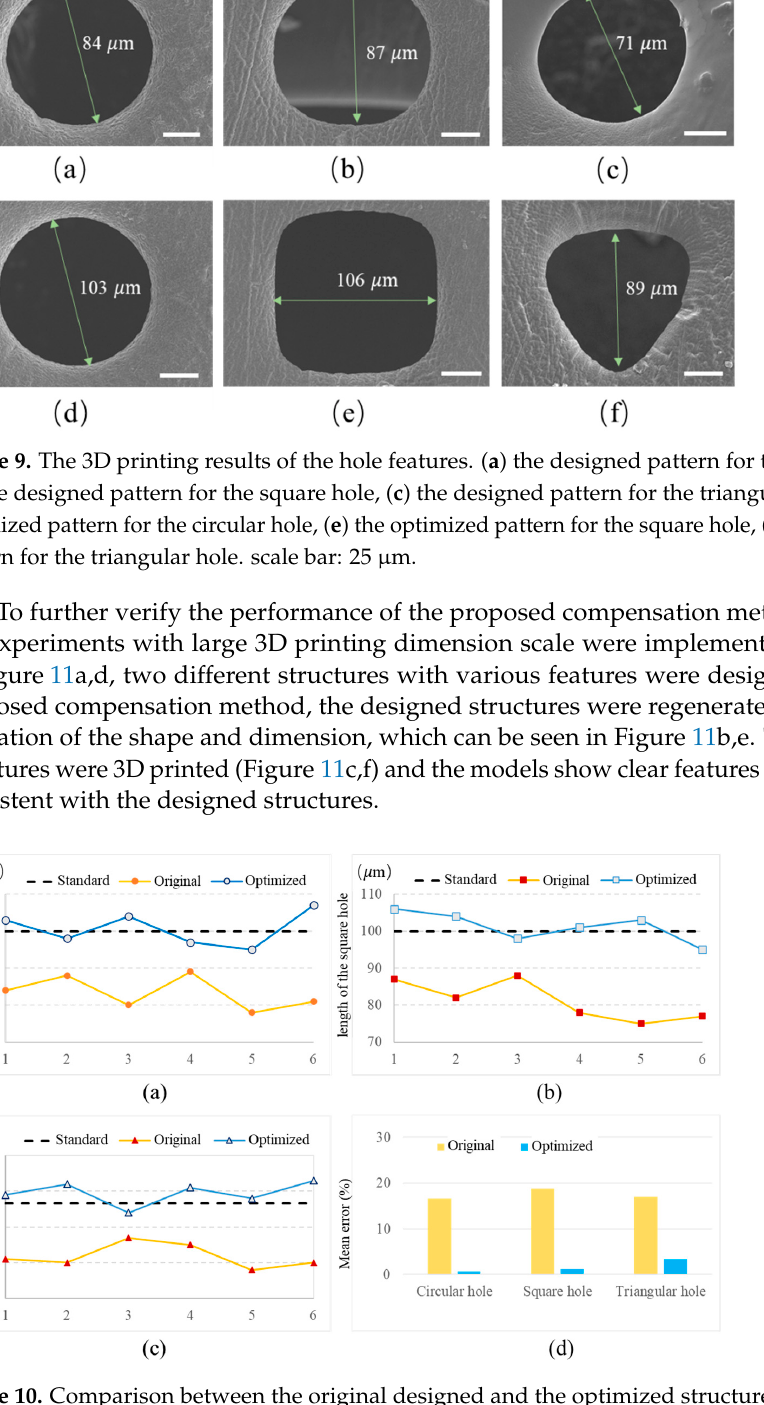
Figure 10. Comparison between the original designed and the optimized structures on dimension accuracy. ( a ) The dimensions for the circular hole, ( b ) the dimensions for the square hole, ( c ) the dimensions for the triangular hole and ( d ) the mean error of each pattern.